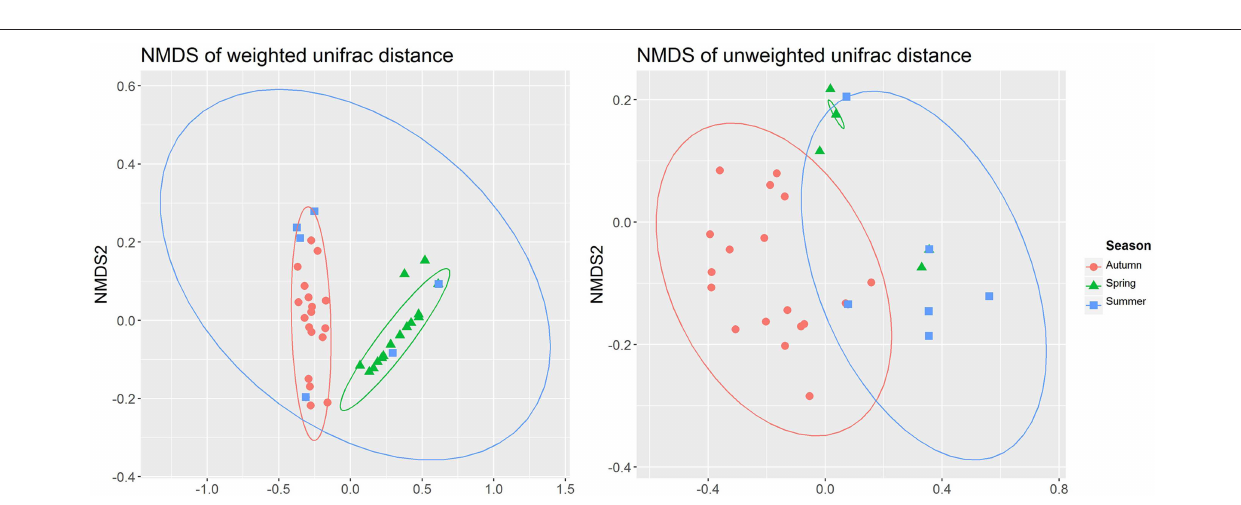
FIGURE 4 | Two-dimensional sorting graph of NMDS